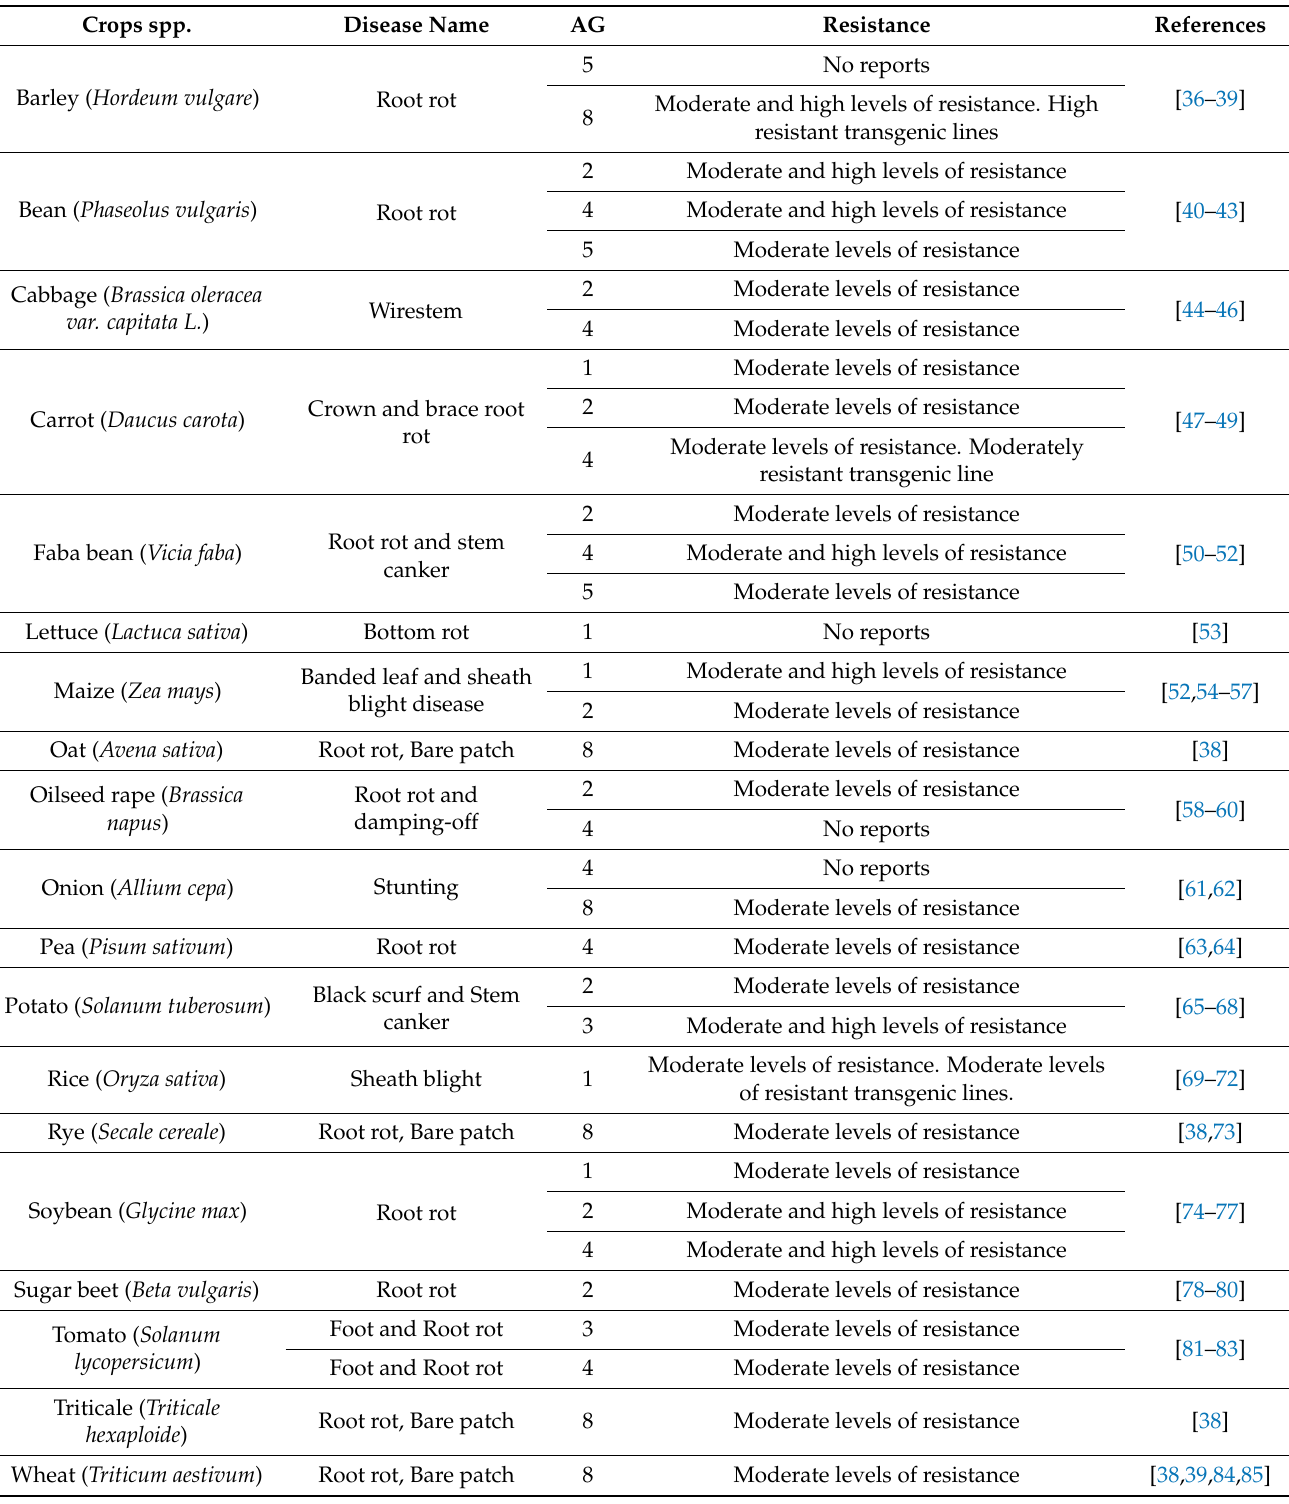
Table 1. Crop species affected by Rhizoctonia solani root